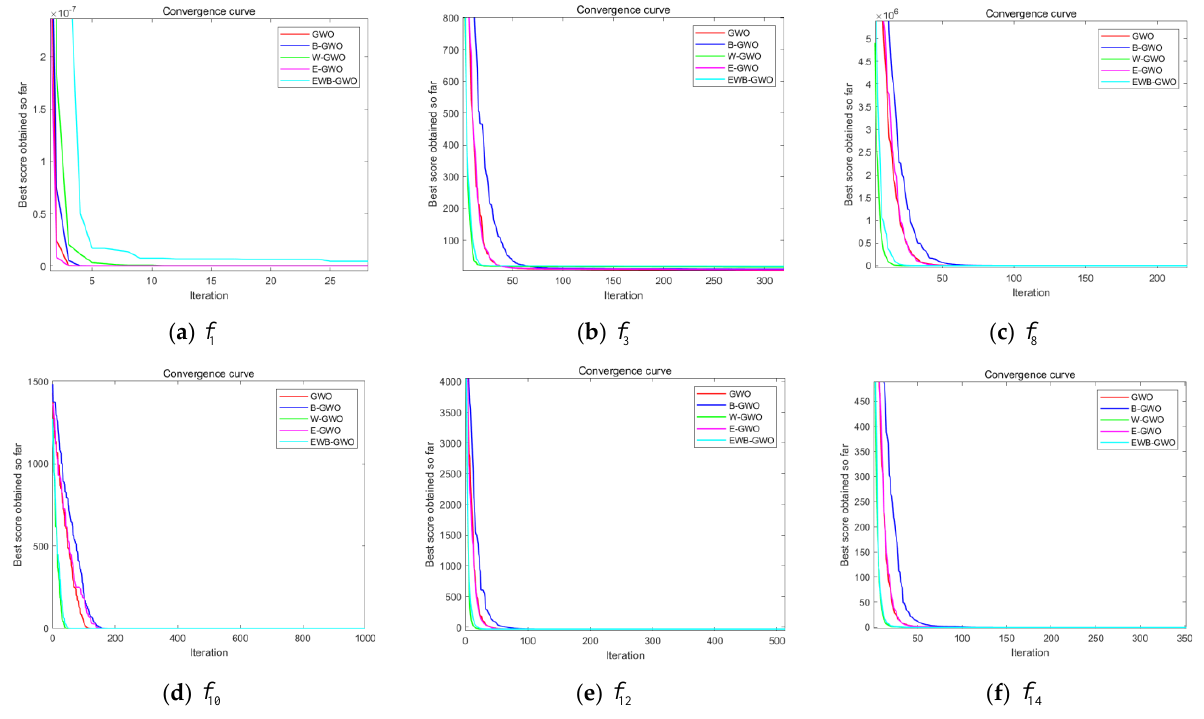
Figure 10. Comparison of convergence curves of GWO, E − GWO, W − GWO, B − GWO, and EWB − GWO with Dim = 50.